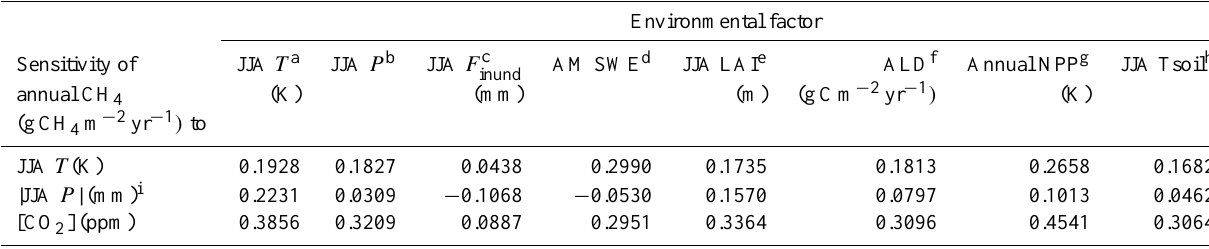
Table 5. Spatial correlation coefficients between sensitivities and environmental factors.